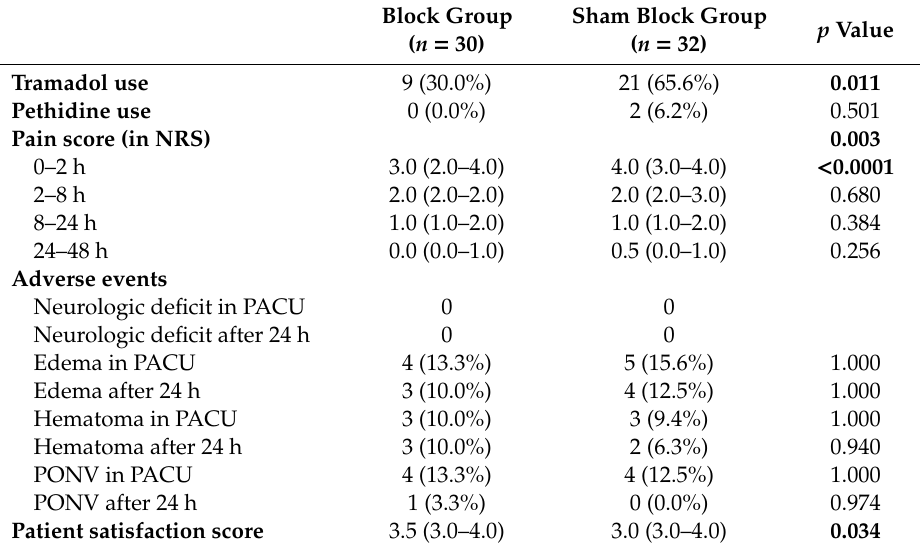
Table 2. Recovery characteristics. The data are presented as the mean ± standard deviation, median (IQR) and number (proportion; %). NRS, numerical rating scale; PACU, post-anesthesia care unit; PONV, postoperative nausea and vomiting.